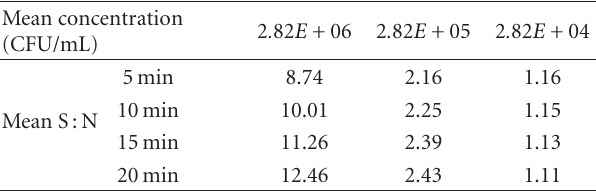
Table 3: Mean S: N for detection of M. tuberculosis by IMS/ATP. Data is averaged from the four replicates